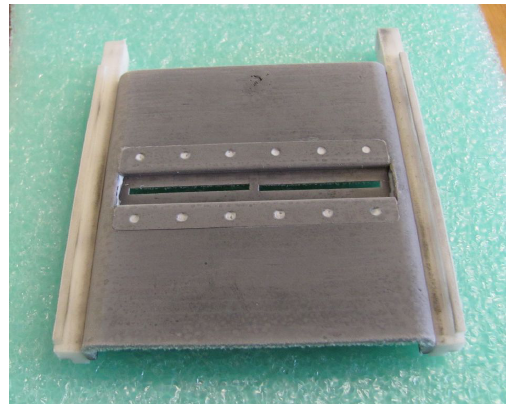
Figure 2: The narrow occulting slot that can be moved just in front of the SALTICAM CCDs to allow for high time resolution (down to ∼ 80 ms)